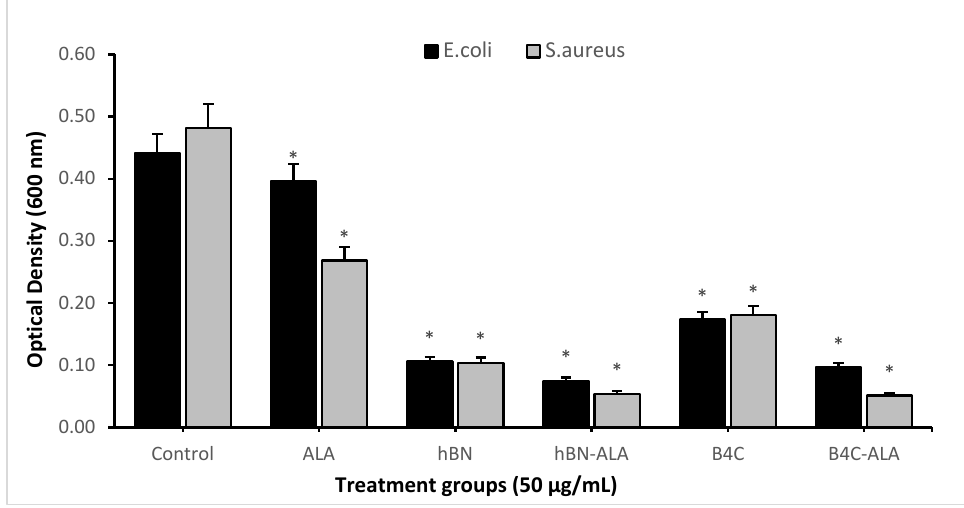
Figure 7. Antimicrobial activity of hBN, hBN ‐ ALA, B 4 C, B 4 C ‐ ALA, and ALA nanoparticles on S. aureus and E. coli bacterial strains for 24 h. Symbol (*) represents statistically significant difference ( p ≤ 0.05) compared to the negative control.